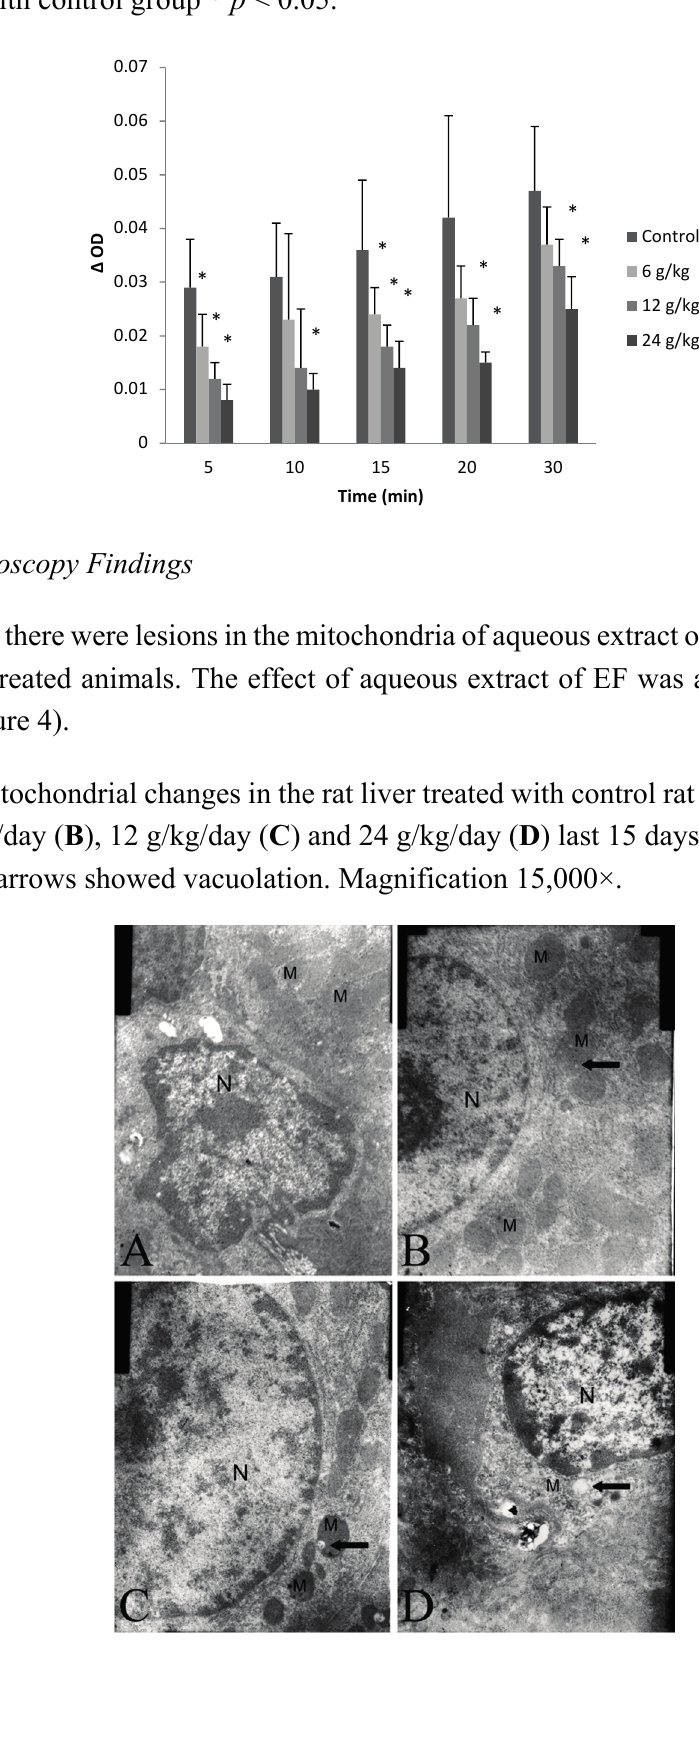
Figure 3. Effects of aqueous extract of EF on mitochondrial permeability transition. Figure showed the decrease in absorbance at 540 nm at different time points of the mitochondria which induced by 20 µmol/L CaCl 2 . Data were presented as mean ± SEM (n = 10). Compared with control group * p < 0.05.